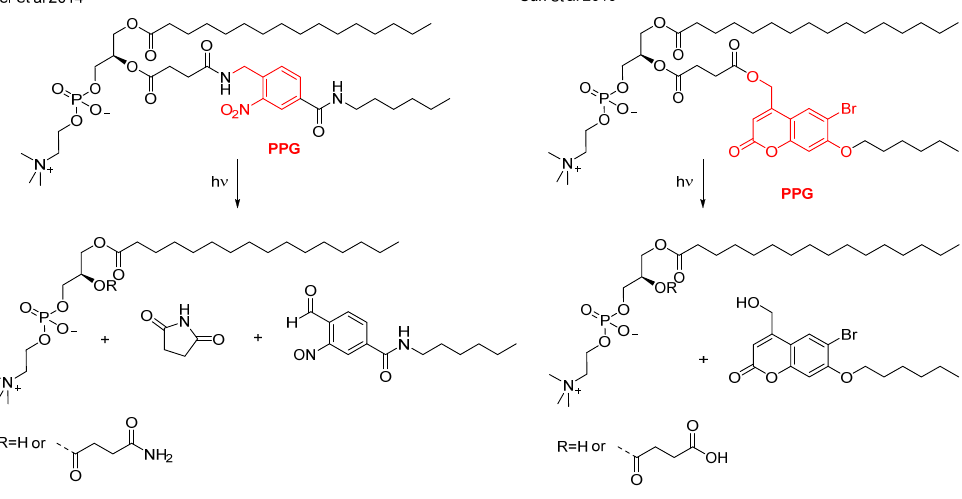
Figure 10. Photocleavable amphihilic lipids for constructing photoresponsive liposomes [63,64].